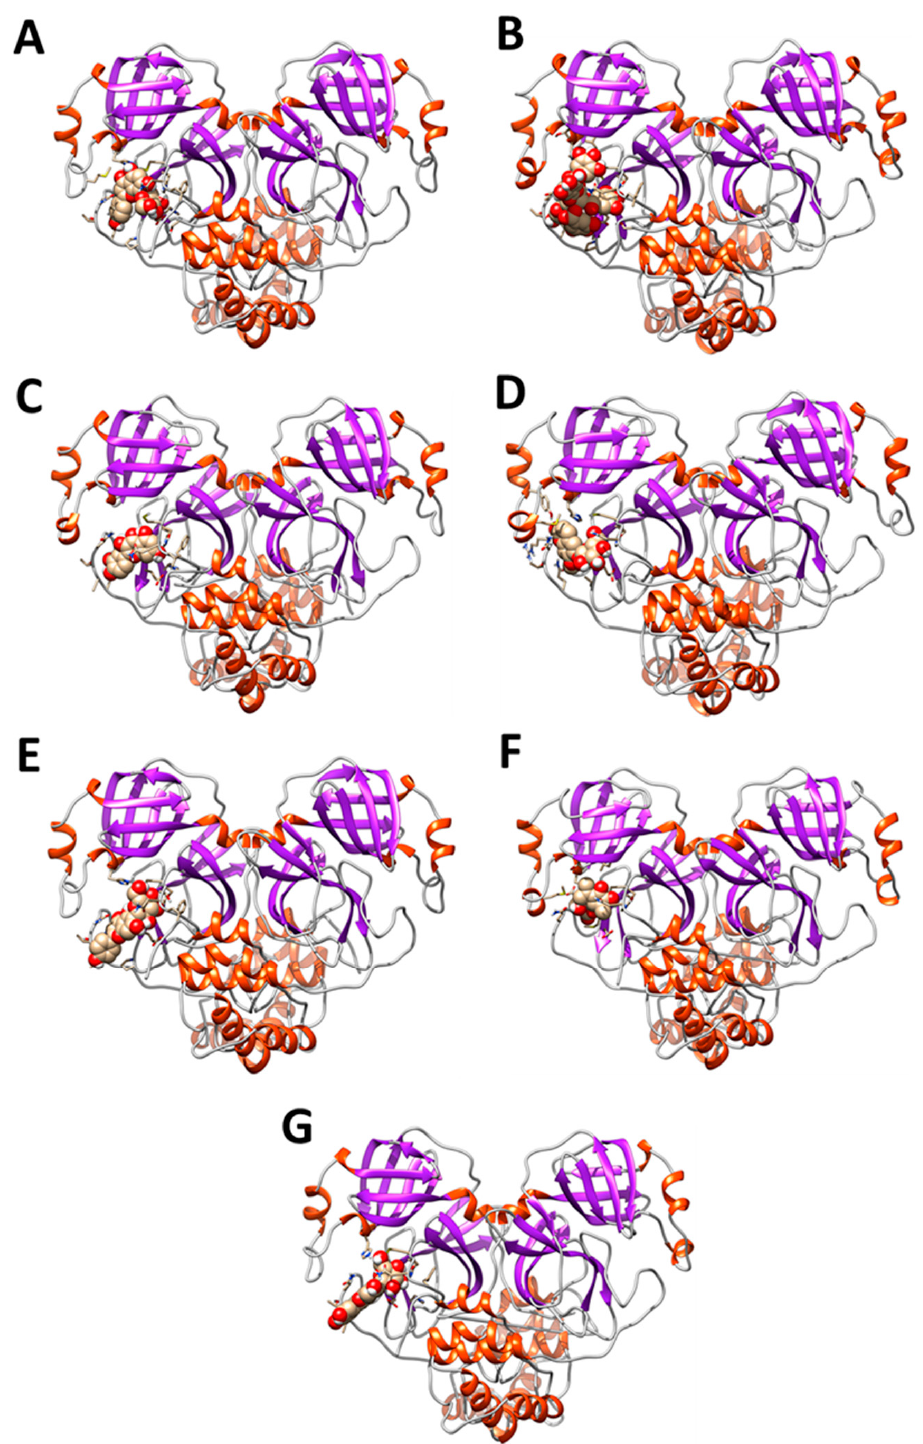
Figure 3. ( A – G ) shows the data related to the distance observed as a function of the simulation time, for the seven simulated systems, between the active site of the protease and each compound. As can be observed, the compounds identified by molecular docking remain stably anchored within the active site of the viral protease.